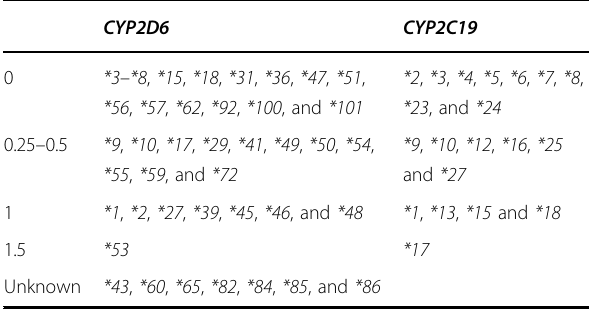
Table 1 Functionality of CYP2D6 and CYP2C19